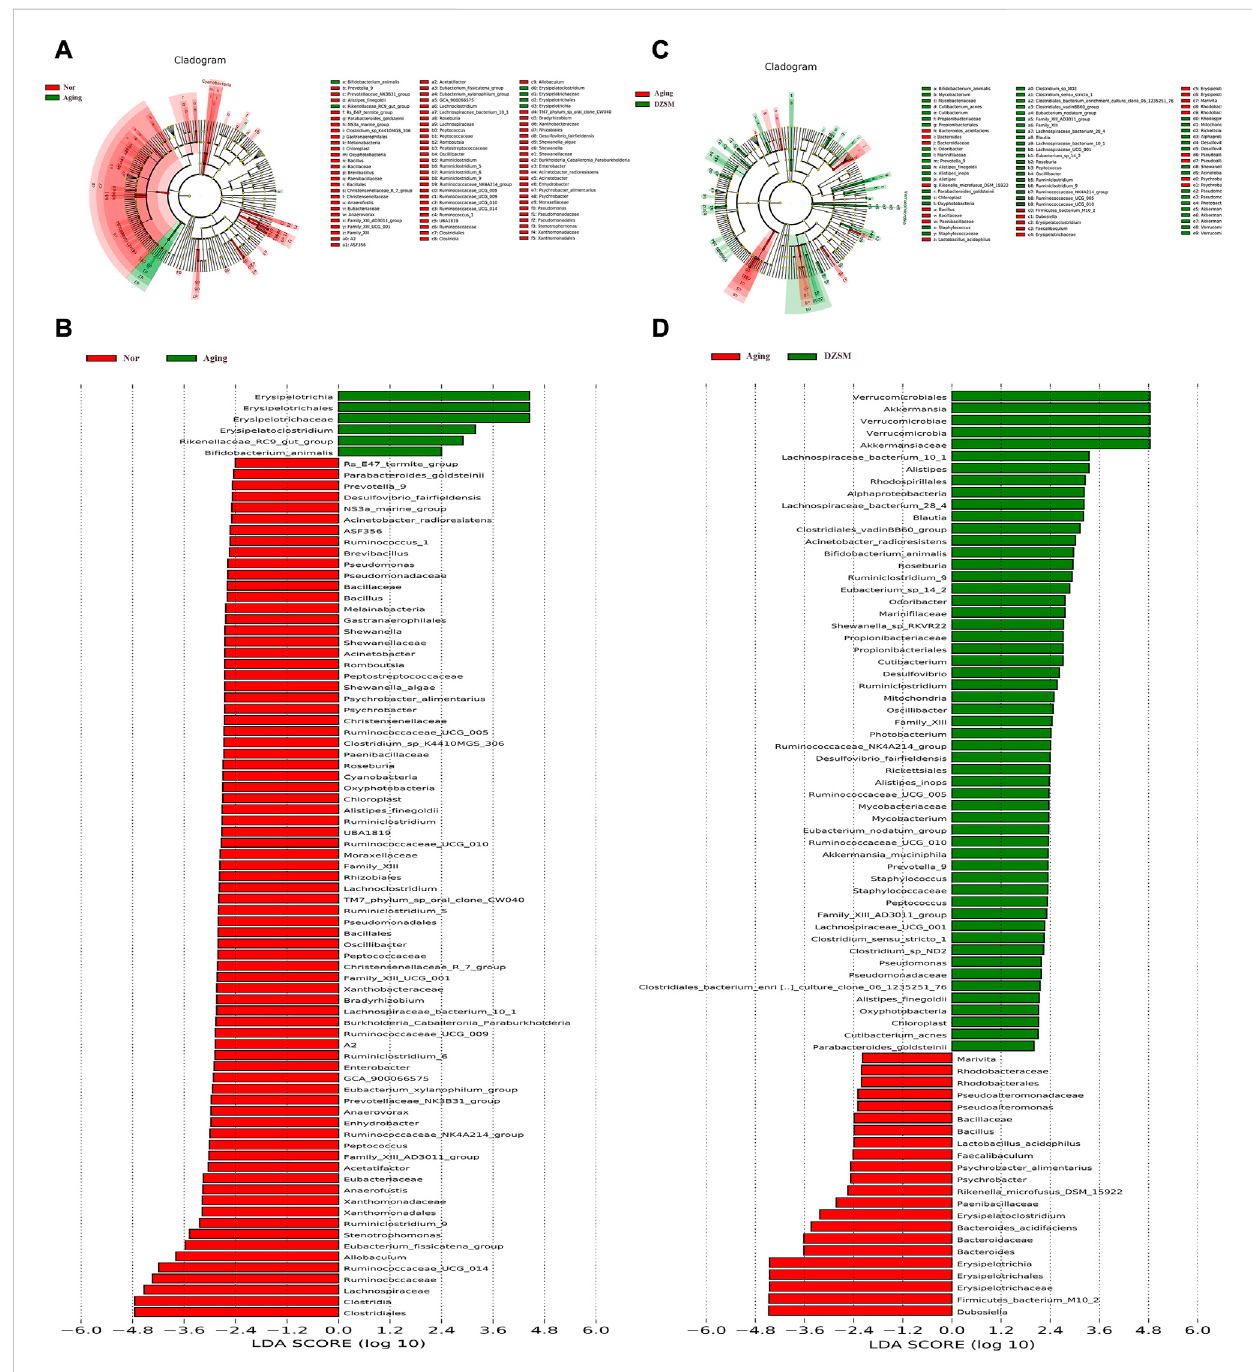
FIGURE 7 Different species abundance on linear discriminant analysis (LDA) effect size (LefSe). (A) Cladogram of Aging vs. Nor groups; (B) LDA scores of Aging vs. Nor groups; (C) Cladogram of DZSM vs. Aging groups; (D) LDA scores of DZSM vs. Aging groups.